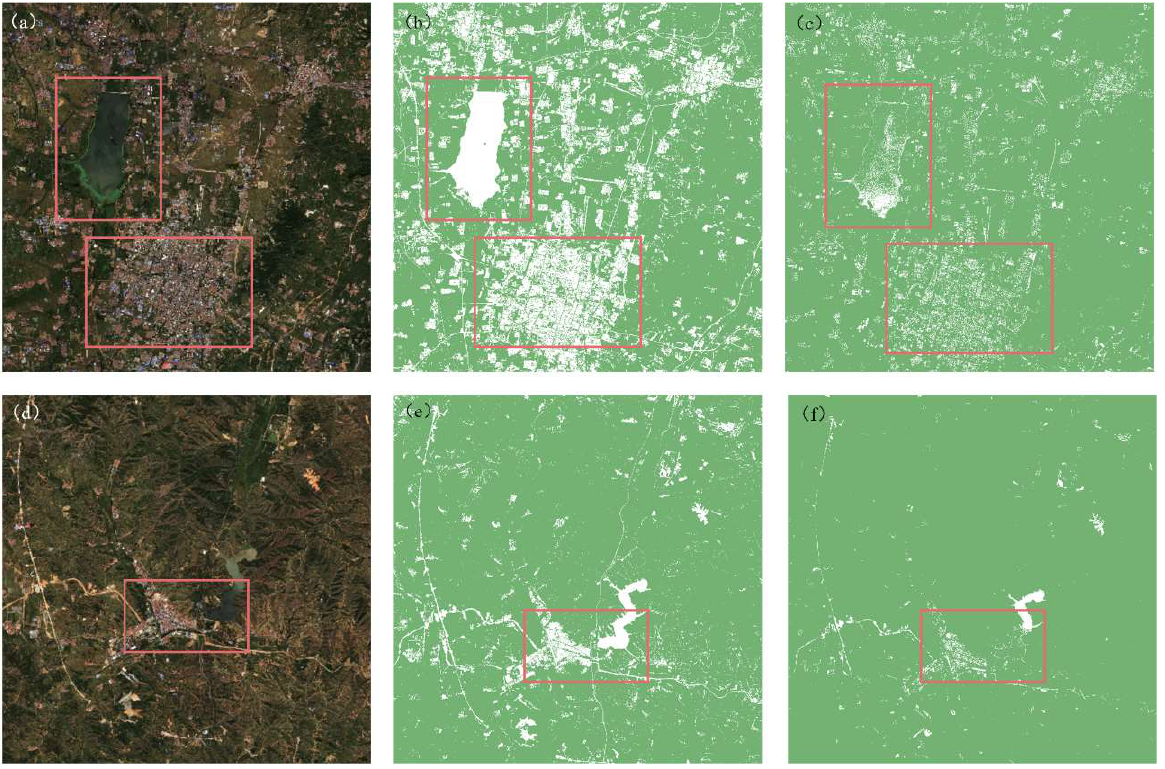
Figure 4. ( a , d ) are sentinel-2 satellite images displayed in true color. ( b , e ) are the results of vegetation identification using NDVI. ( c , f ) are the results of vegetation identification using EVI. Green areas indicate vegetation and white areas indicate non-vegetation. In the red squares are impervious surface and water.